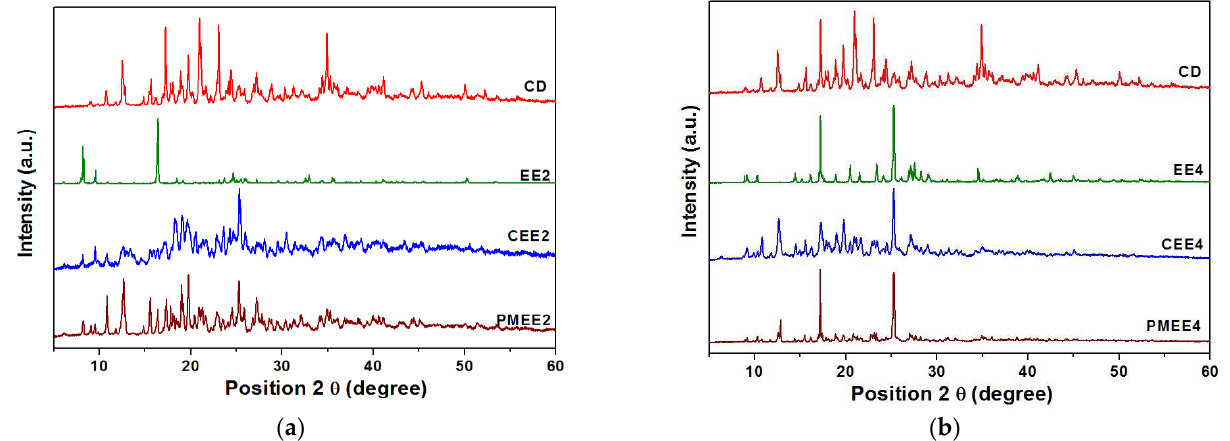
Figure 1. XRD spectra of β -cyclodextrin, ethyl ester, inclusion complex, physical mixture: ( a ) ethyl 2-(2-((2-chlorophenyl)carbamoyl)phenoxy)acetate series; ( b ) ethyl 2-(2-((4-chlorophenyl) car- bamoyl)phenoxy)acetate series.